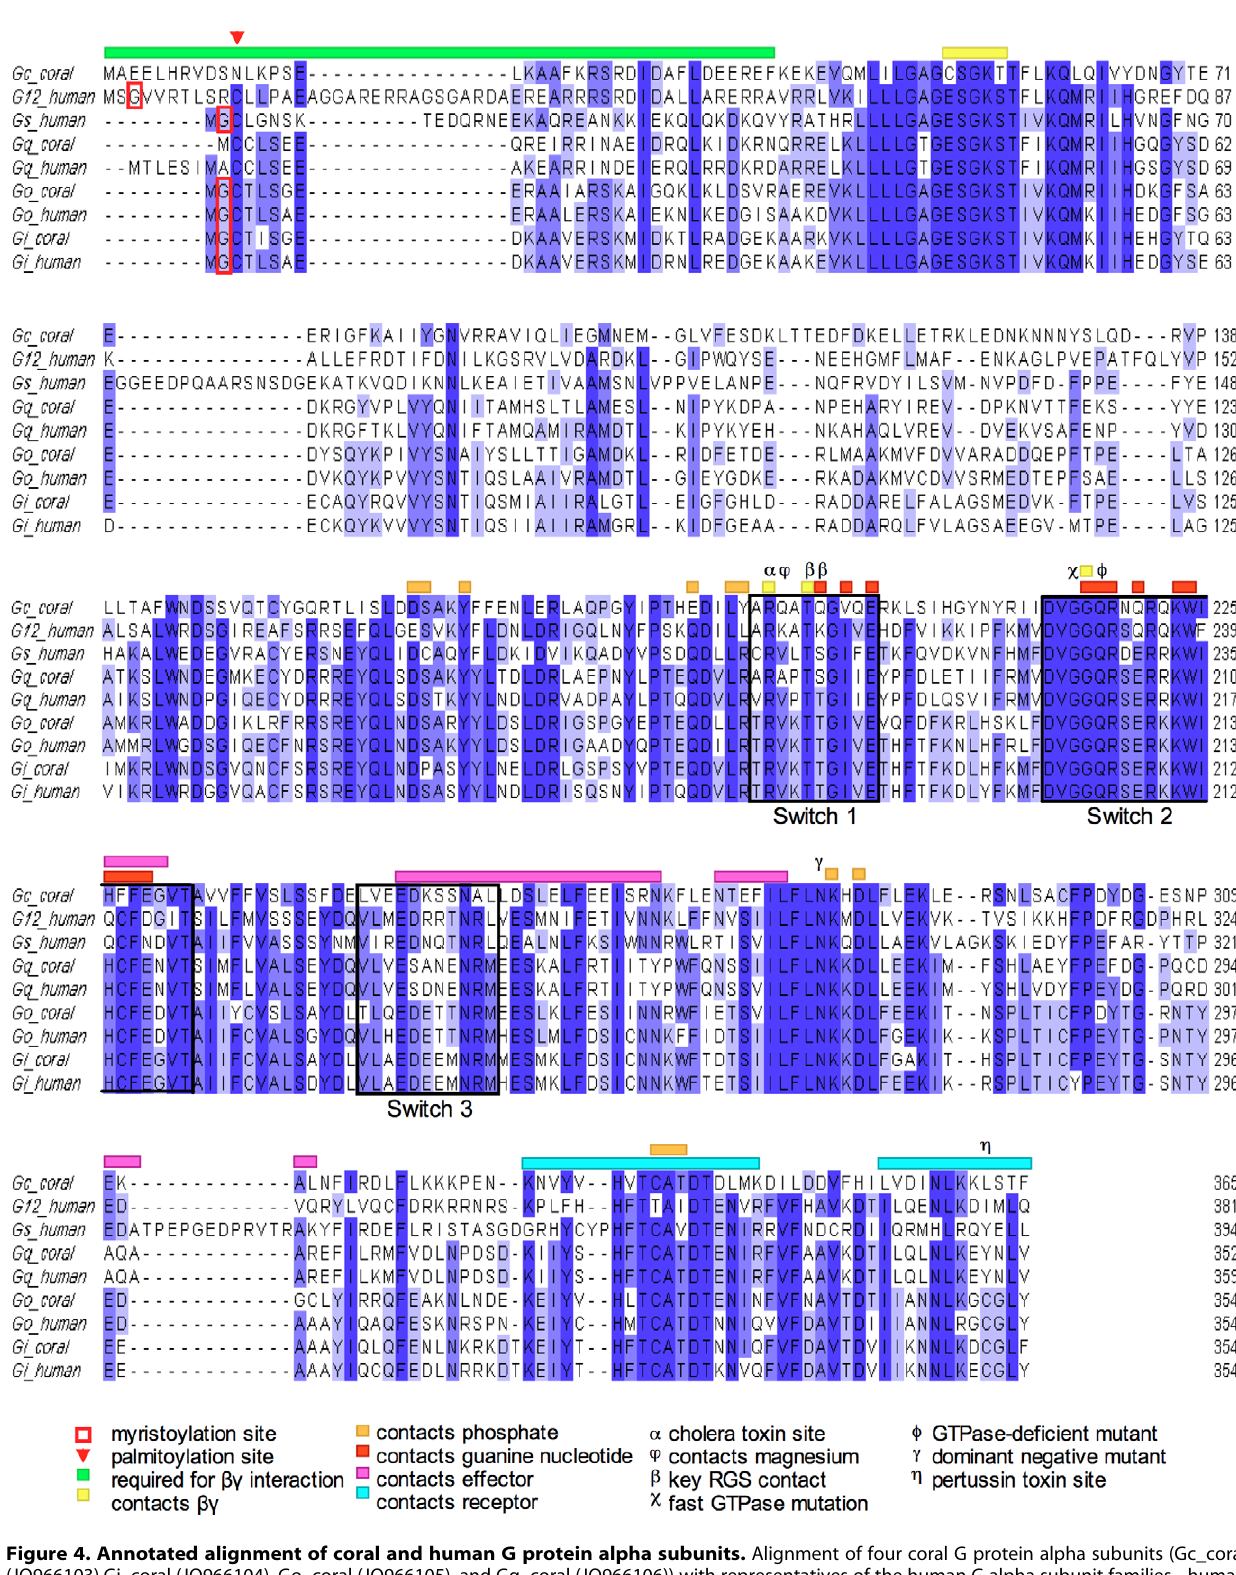
PLOS ONE | www.plosone.org 5 December 2012 | Volume 7 | Issue 12 |